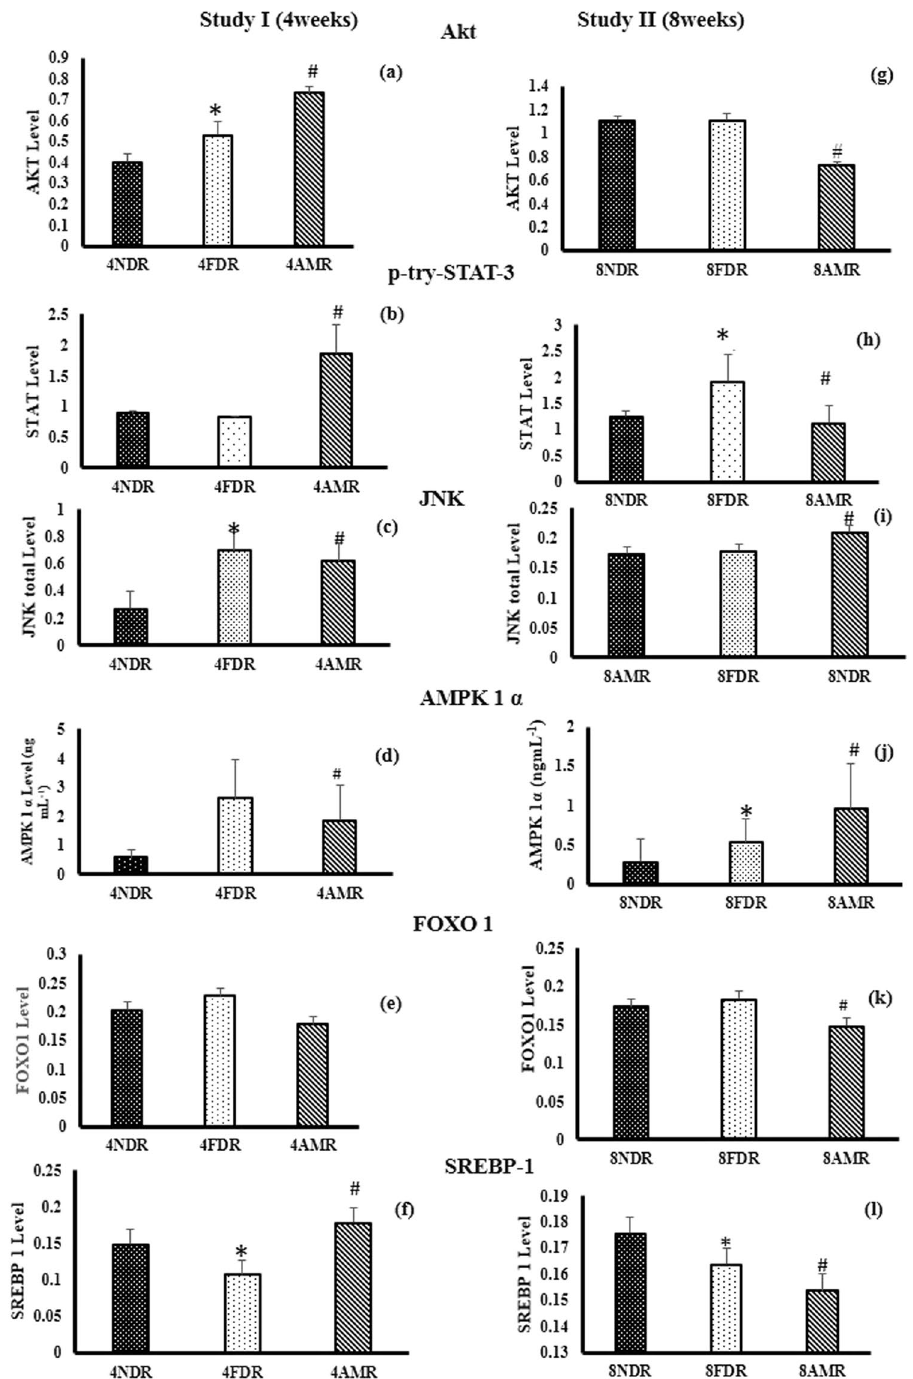
Figure 4. Effect of AM-HM on messengers of hepatic insulin signaling cascade-Akt, signal transducer and activator of transcription 3 (p-tyr-STAT-3), c-Jun N-terminal kinase (JNK1/2), 5 ′ AMP-activated protein kinase (AMPK-1 α ), Forkhead box protein O1 (FoxO1), sterol regulatory element-binding protein 1c (SREB1c).